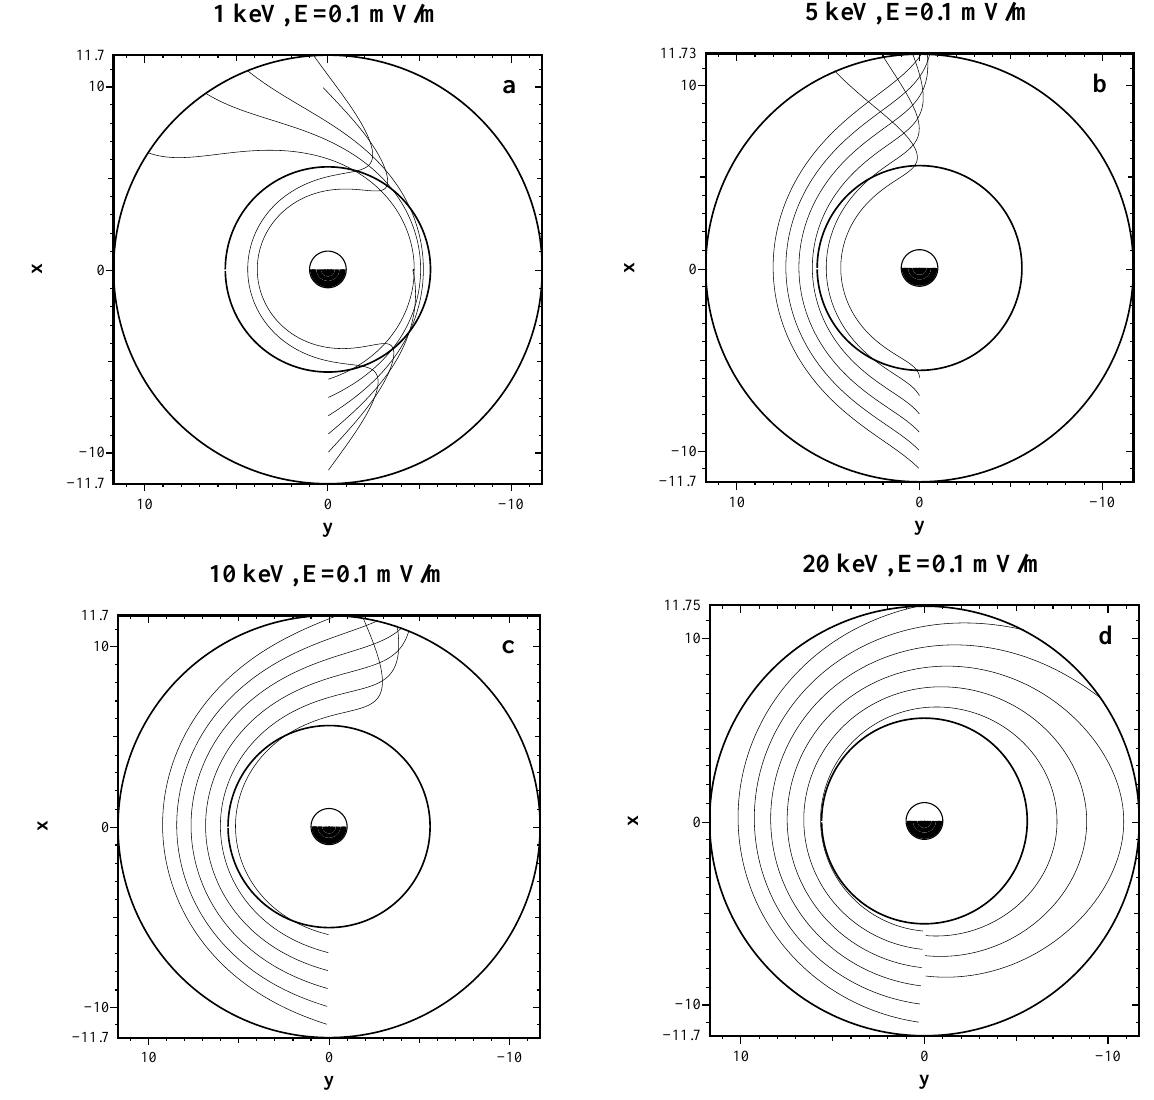
Fig. 8. Drift paths of equatorial protons launched from MLT 24 for energies 1keV (a) , 5keV (b) , 10keV (c) and 20keV (d) . Circles corresponding to 65 and 73ILAT are drawn, approximately corresponding to the range of data. Dipole magnetic field and a uniform duskward electric field of 0.1mV/m are